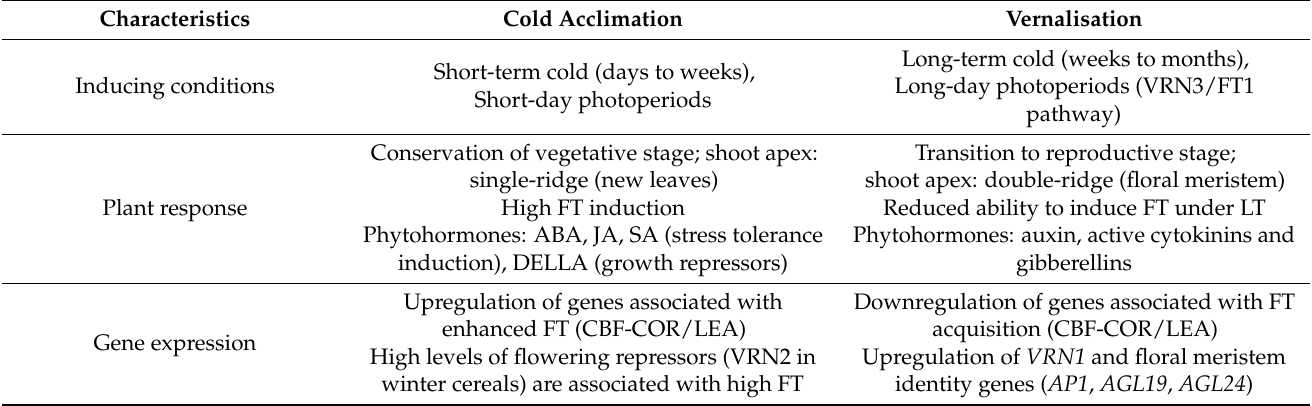
Table 1. A comparison of cold acclimation and vernalisation processes and their impacts on winter Triticeae.